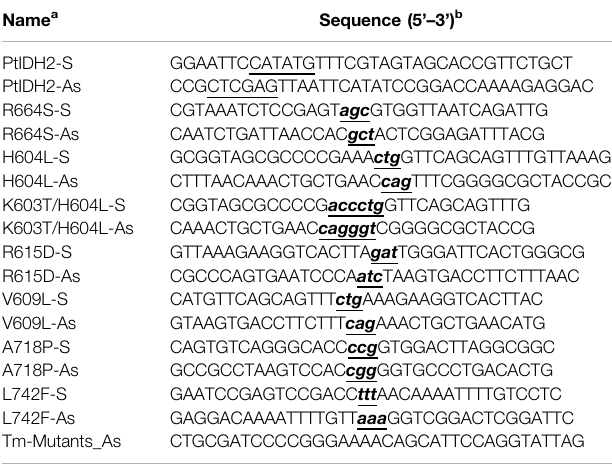
TABLE 1 | The sequences of the primers used in this